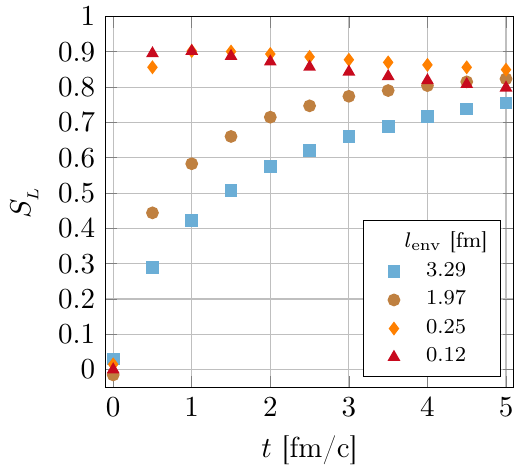
Figure 6 . Time evolution of the linear entropy for di(cid:11)erent correlation lengths of the environment, starting o(cid:11) with an initial density matrix corresponding to a thermal scattering state ( (cid:14) = 2 : 5 fm and p = 0 : 69 (cid:0)